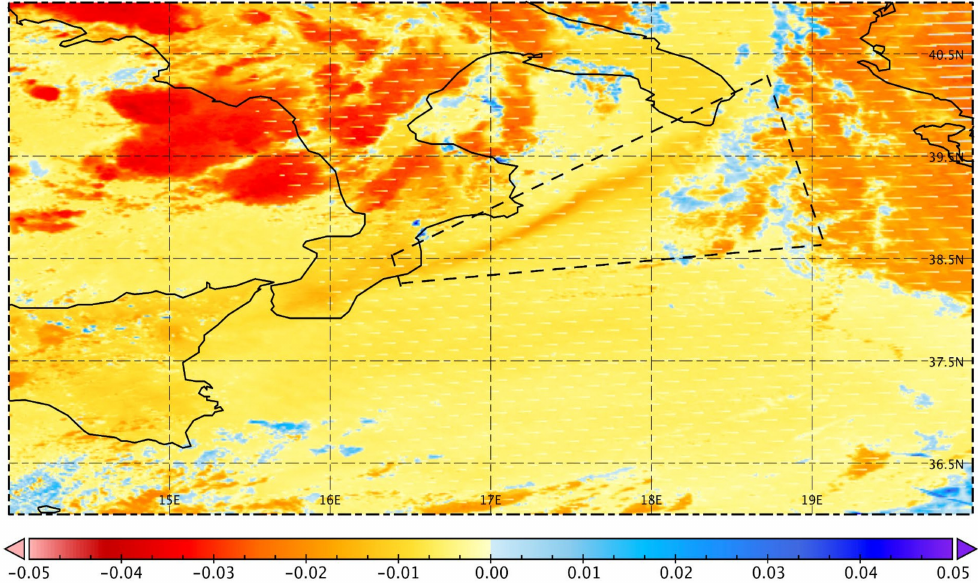
Figure A2. Normalized brightness temperature difference (DT) of the VIIRS thermal infrared channels 15 and 16. The dotted region highlights the presence of ash ( DT < 0) and ice ( DT >